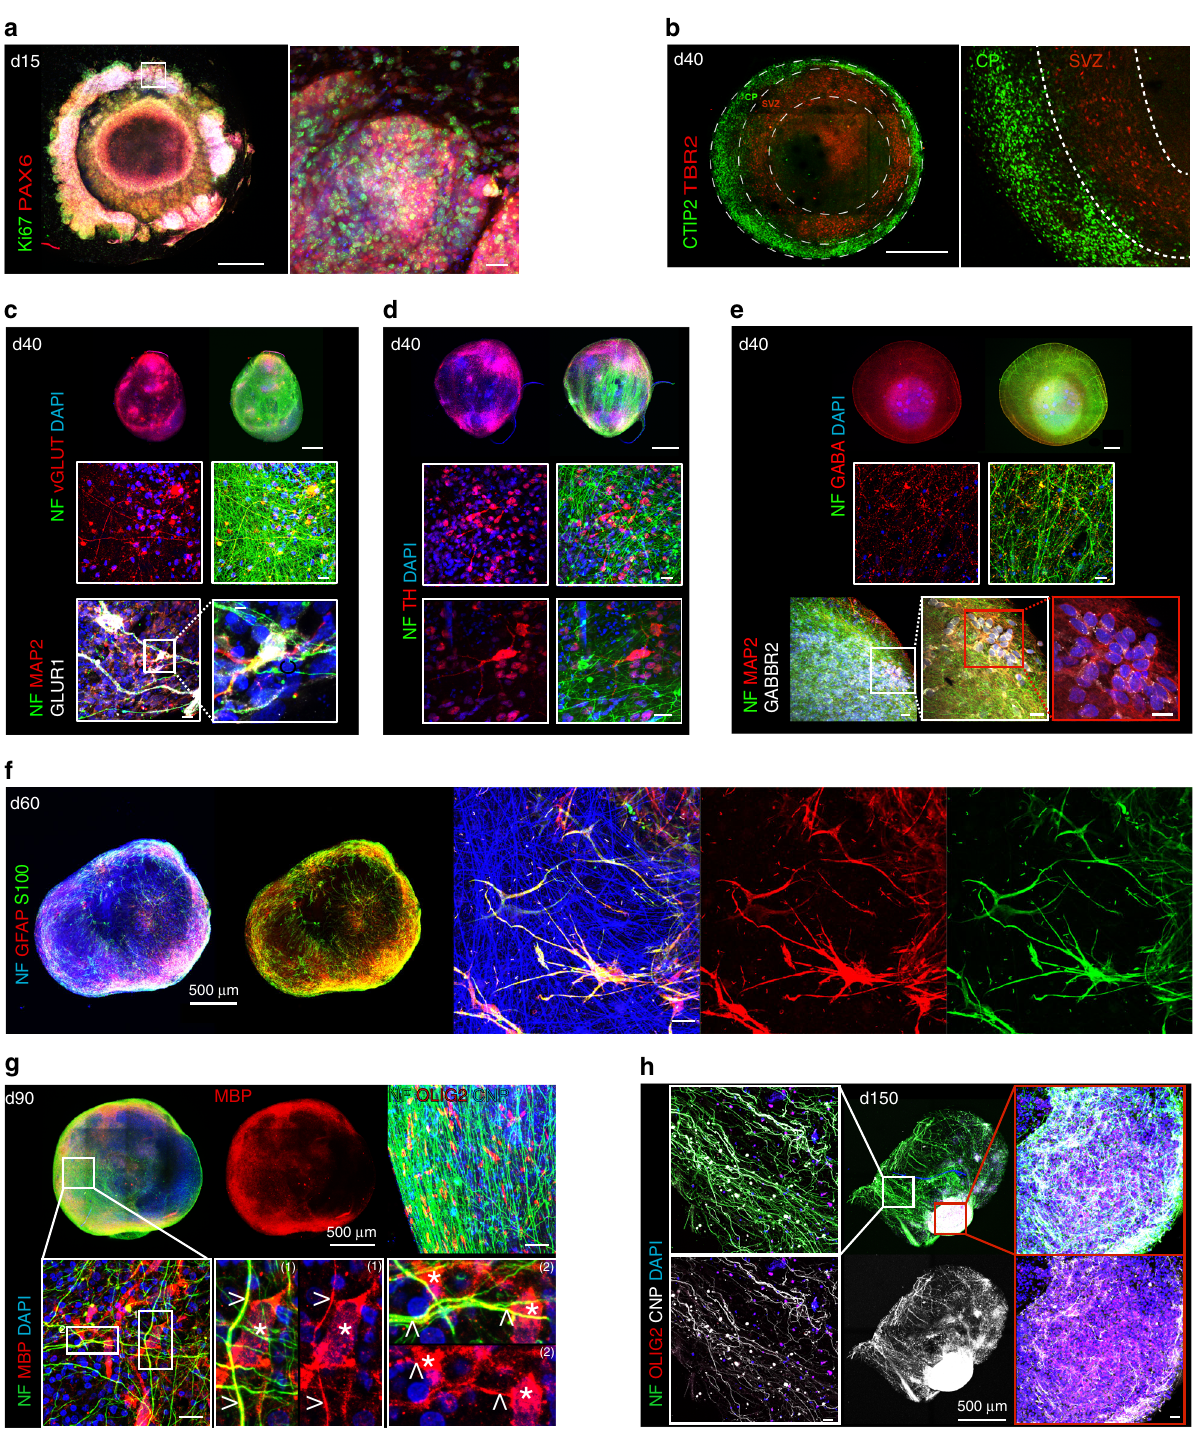
Fig. 3 Cellular composition of BENOs in different times of differentiation. a Representative overview and higher magni fi cation images of indicated region of a d15 BENO showing proliferating NPCs (PAX6 + /Ki67 + ; refer to Supplementary Fig. 4a for the individual confocal planes). b Distinguishable concentric surrogate subventricular zone (TBR2 + ) and a cortical plate (CTIP2 + ) in d40 BENO. c – e Excitatory (vGLUT + , TH + ) and inhibitory (GABA + ) neurons as well as their respective receptors (GLUR1, GABBR2) in d40 BENOs. f Overview (left) of a d60 BENO stained for astrocyte markers (GFAP + /S100 β + ) and neuronal axons (NF + ); close-up views (right) of GFAP + /S100 β + cells with typical astrocyte morphology. g Detection of oligodendrocyte progenitors (OLIG2 + ) and oligodendrocytes (MBP + /CNP + ) in d90 BENO. Inserts 1 and 2 highlight MBP + oligodendrocytes (*), which contribute to myelination of axons (<). h , On d150 a higher number of mature oligodendrocytes and myelinated axons appeared. All data presented on this fi gure derive from at least three independent experiments with similar results. Scale bars: overviews 200 µ m, close-up views 20 µ m, unless indicated